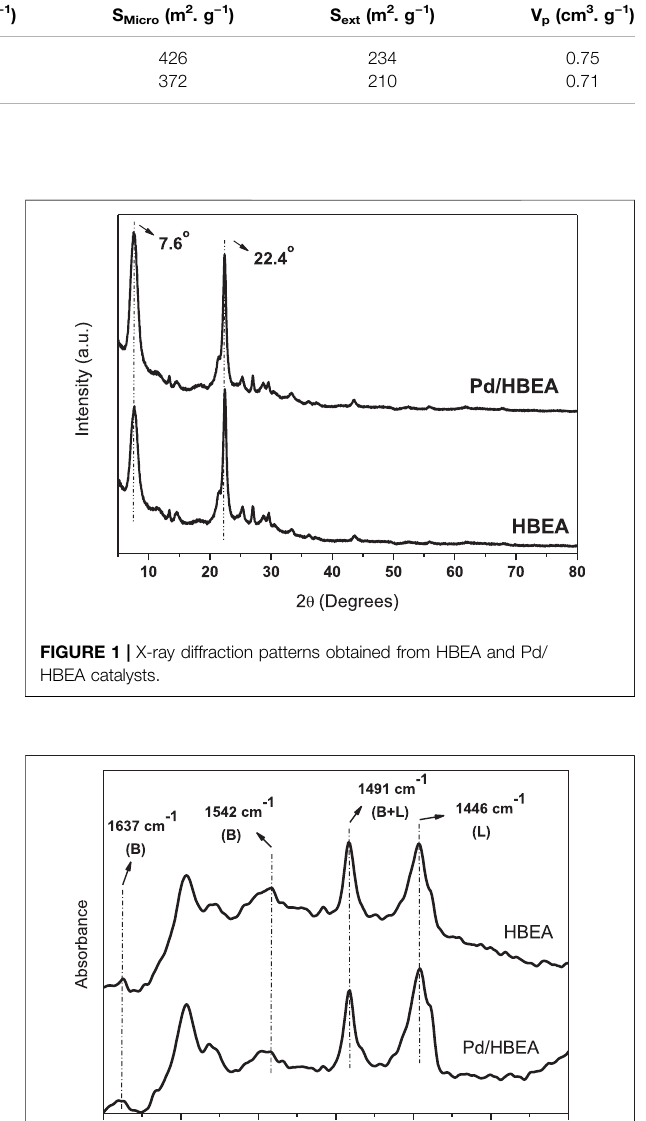
TABLE 1 | Elemental composition and textural properties of HBEA and Pd/HBEA catalysts. Catalyst